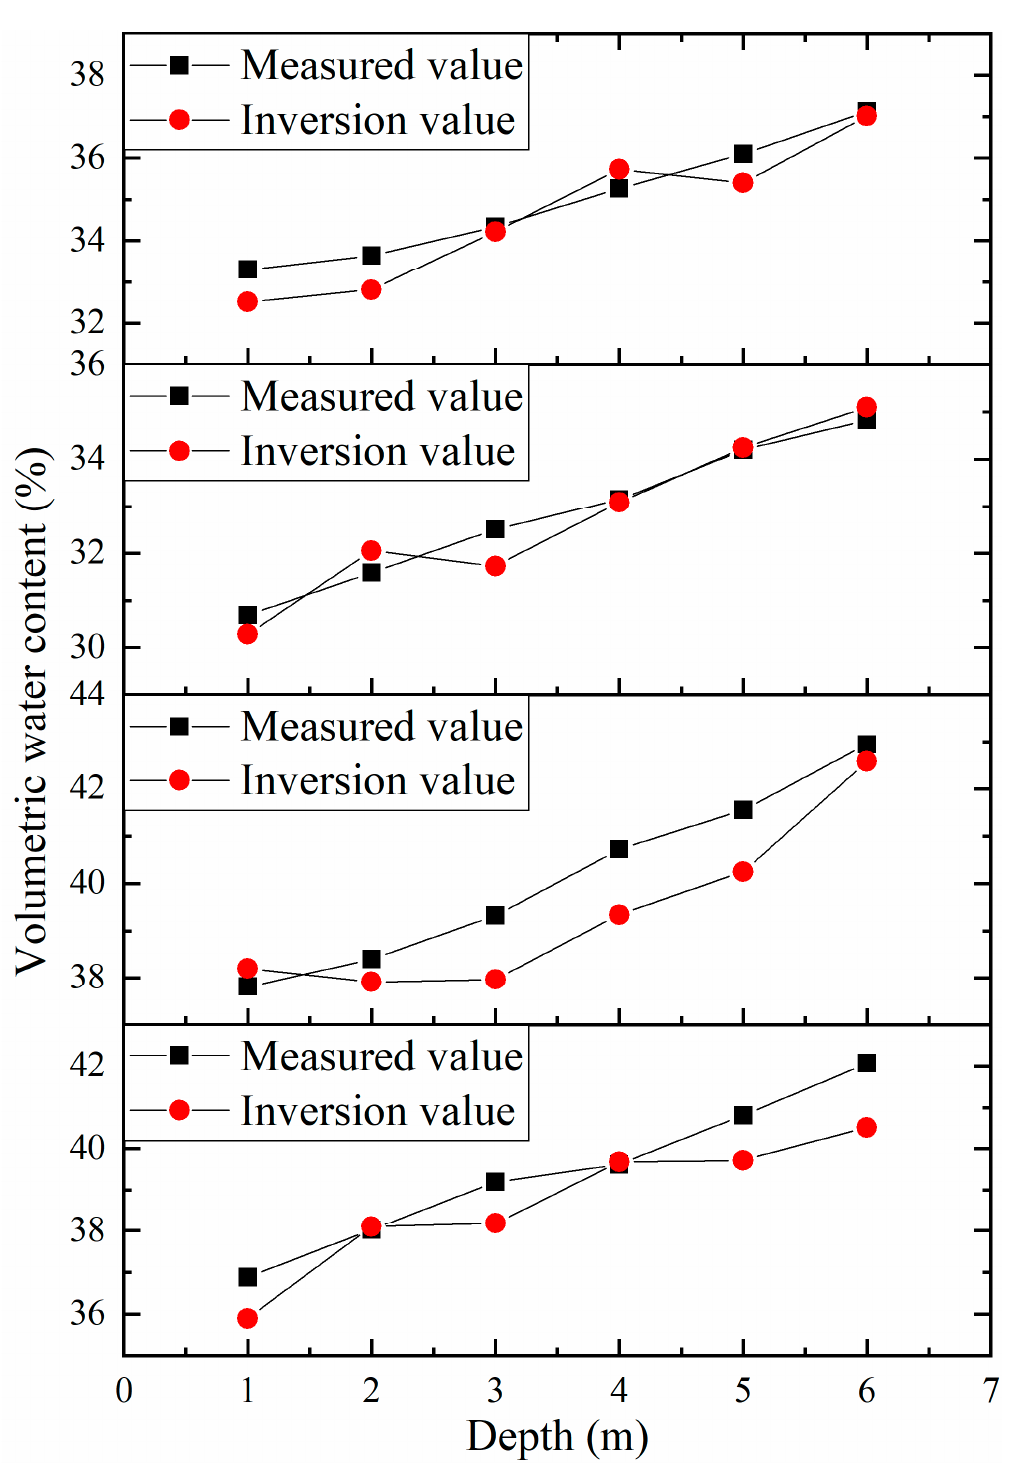
Figure 19. Comparison of the measured and inversion values of volumetric moisture content.